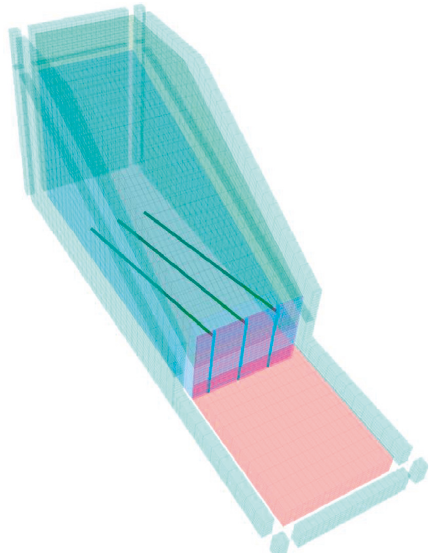
Figure 8: Three-dimensional model of the anchor pile.